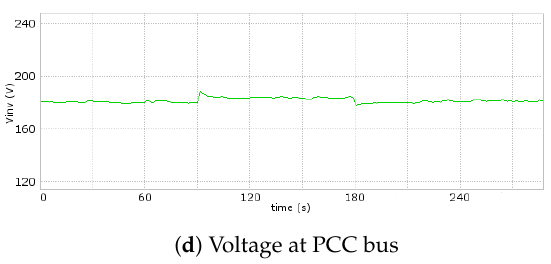
Figure 22. Experiment results of droop power control on synchronous generator connected